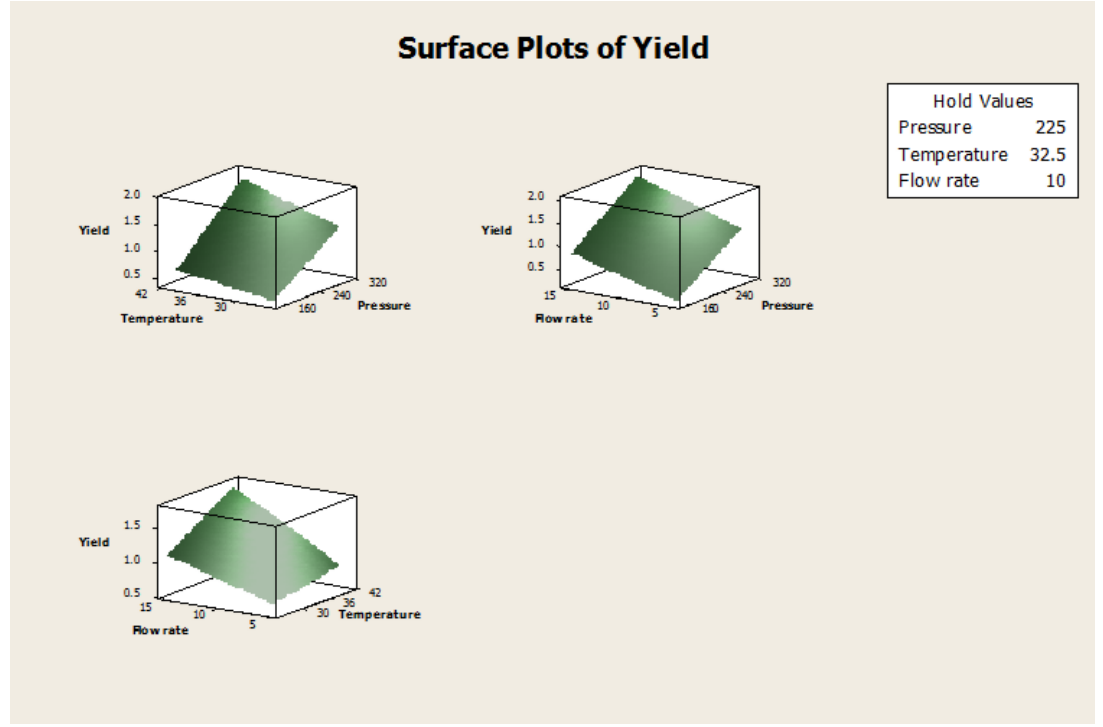
Figure 10. Surface plots of yield vs. pressure, temperature, and flow rate.